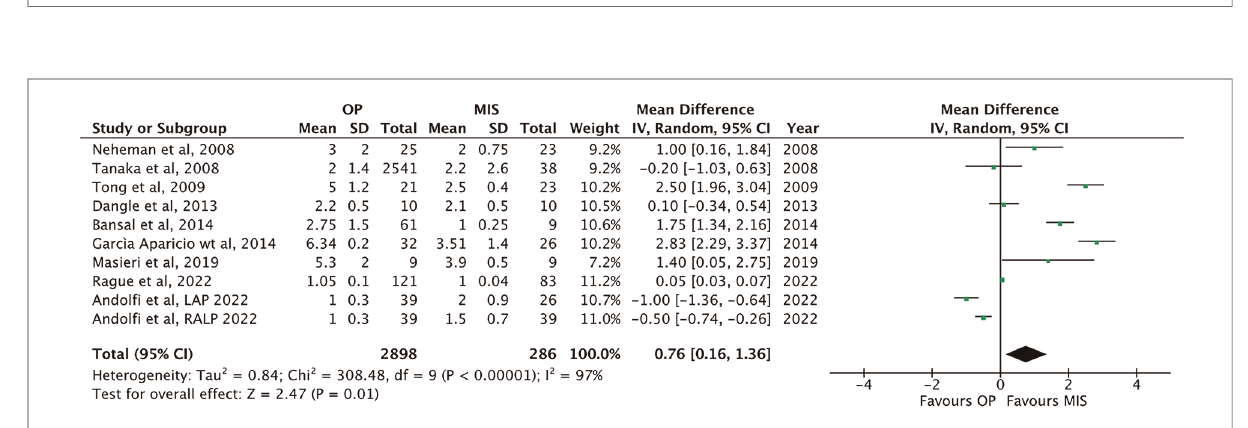
FIGURE 4 Forest plot comparison of operative time at procedure between OP and MIS in infants.